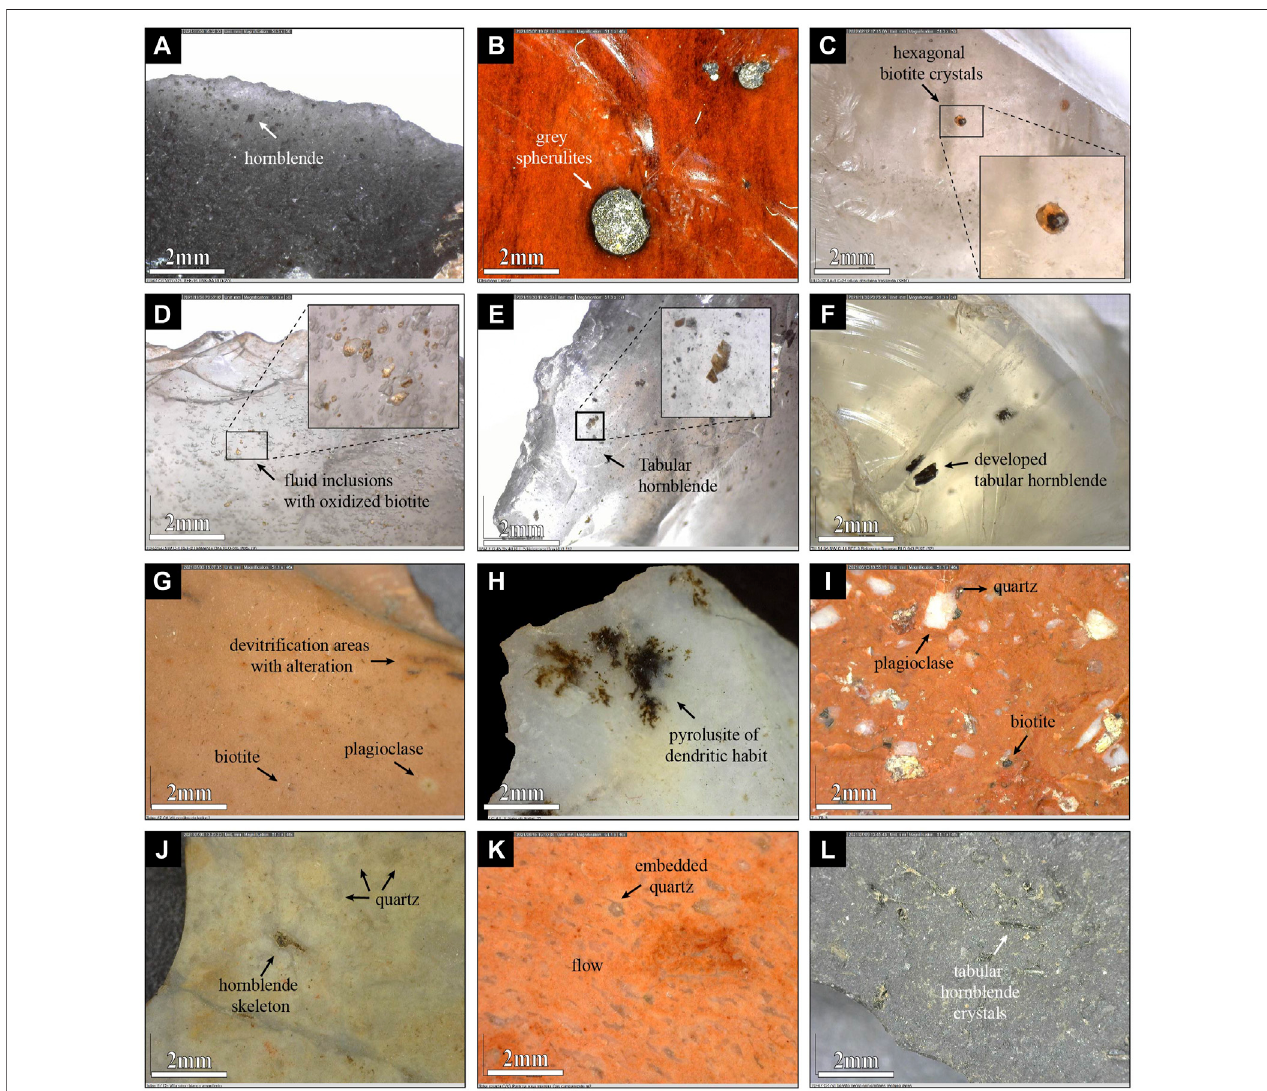
FIGURE 13 | Lithic raw materials from unknown and extra-local sources: (A) ; opaque gray obsidian (OB-3); (B) Shiny black-red obsidian (OB-6); (C) translucent obsidian(OB-8); (D) translucentobsidianwith fl uidinclusions(OB-7); (E) translucentobsidianwithinclusions(OB-7) (F) translucentobsidianwithblackinclusions(OB-9); (G) Brownsiliceousrockwithreddishspots(SR-6); (H) whitechertwithblackspots(SR-4); (I) reddacitictuffwithwhitecrystals(TF-3); (J) white-yellowsilici fi edrock(SR- 5); (K) Pink tuff whith fl ow (TF-6); (L) Black andesite with tabular hornblendes (AN-6).